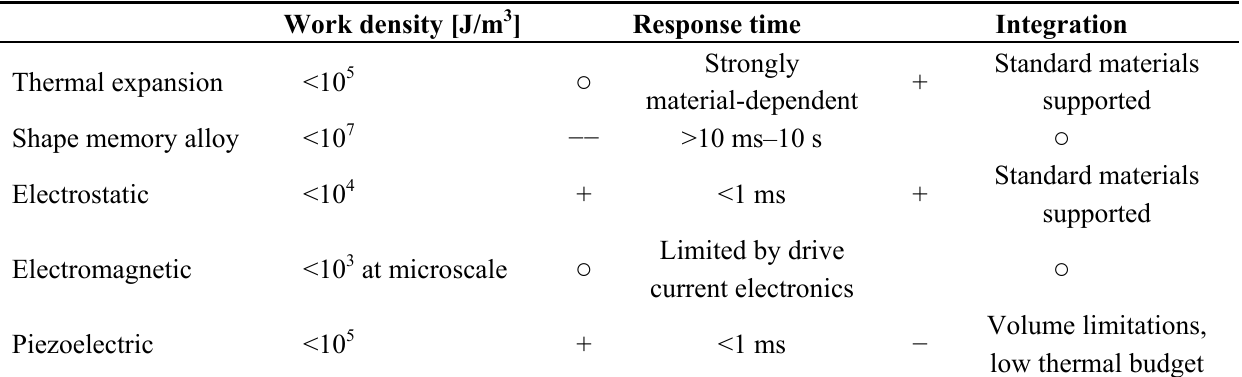
Table 4. Summary of the actuator types described in Section